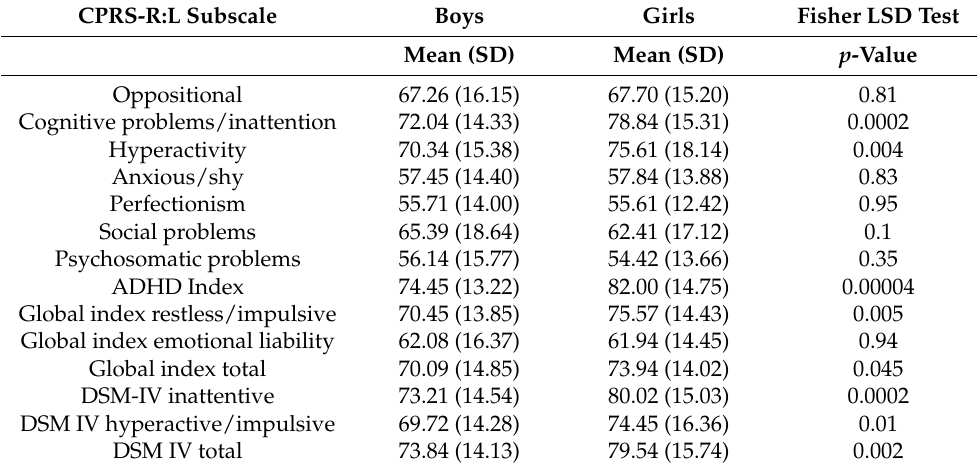
Table 1. Results of comparison between boys and girls with ADHD in CPRS-R:L